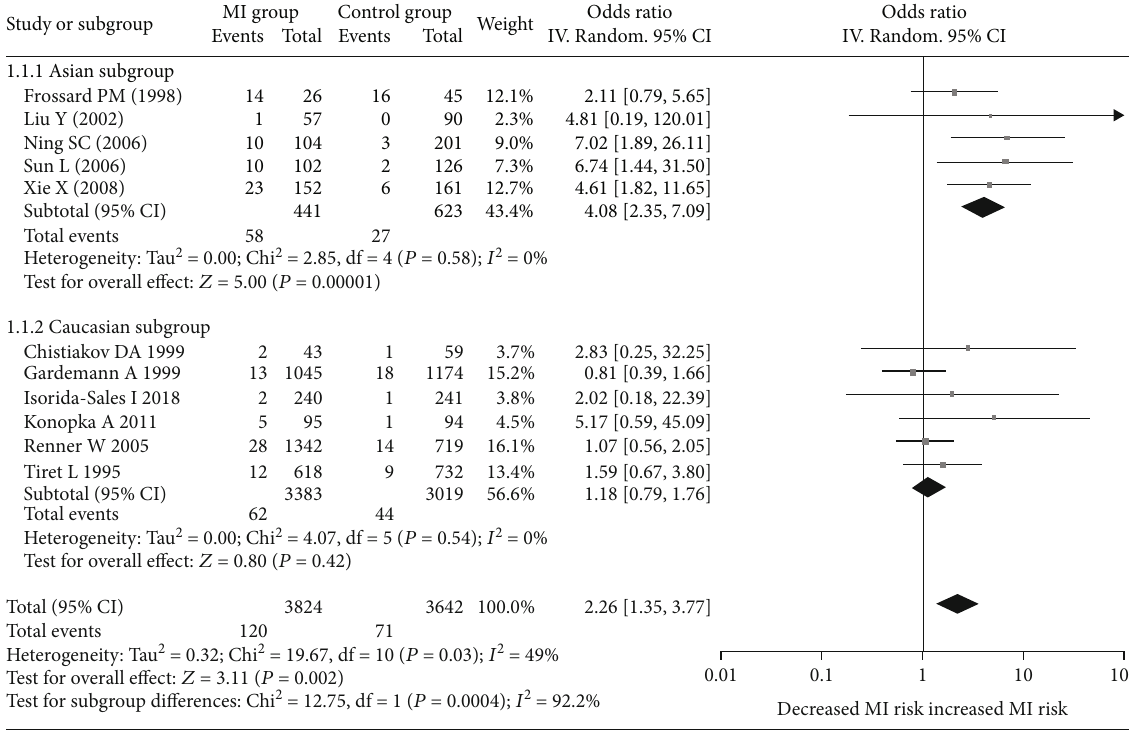
Figure 1: Forest plot of AGT p.Thr174Met polymorphism associated with myocardial infarction strati fi ed by ethnicity using a recessive genetic model (MM vs.